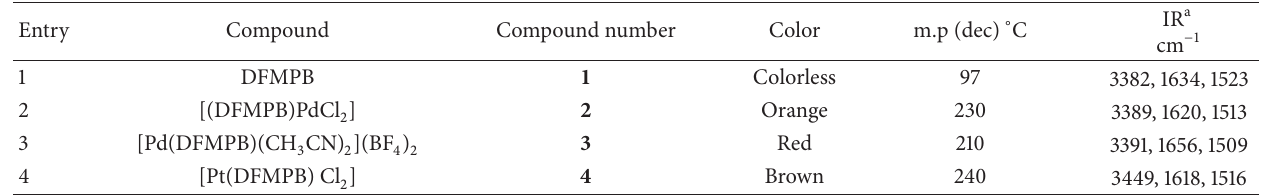
Table 1: Analysis of the compounds a .